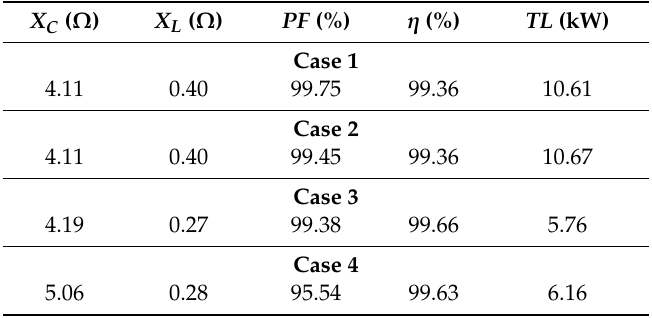
Table 3. Simulated outcomes for the presented optimization approach.